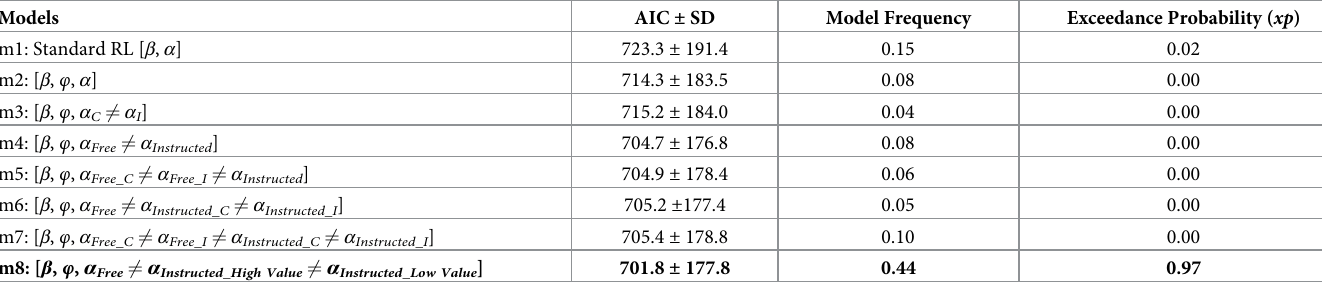
Table 1. Model comparison across the extended model space.